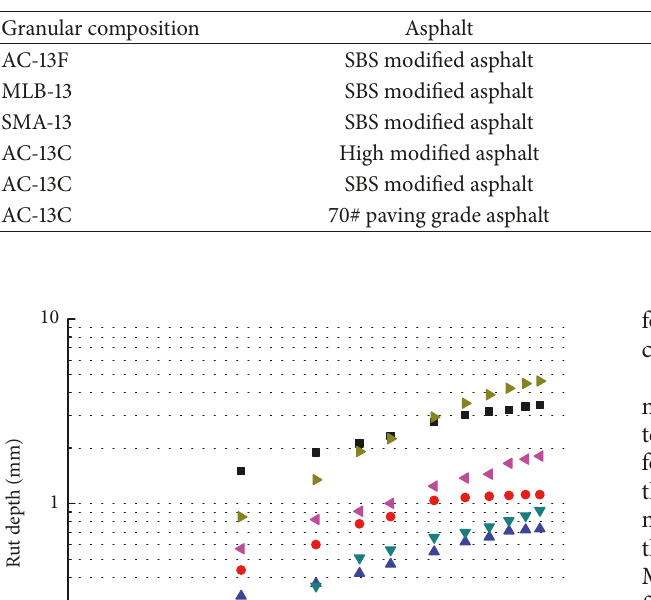
Table 3: Results of the Chinese standard rutting test.